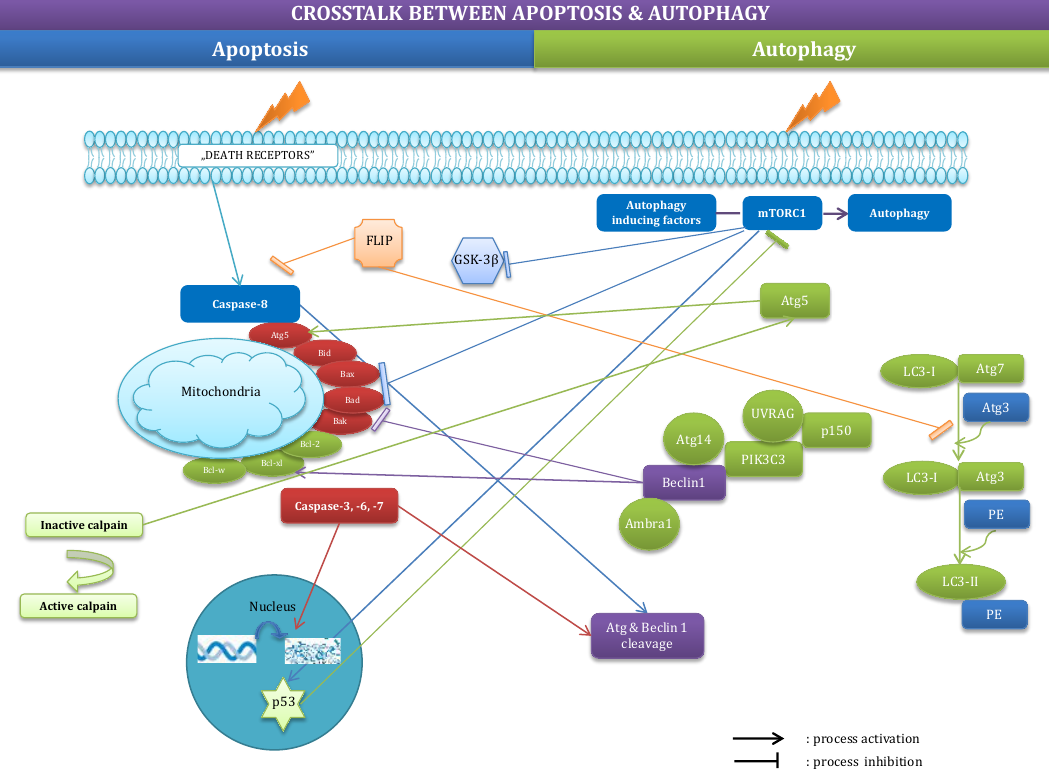
Figure 3. Crosstalk between apoptosis and autophagy. These processes interfere with themselves, mainly with regard to the BCL2 protein family, p53, and Atg5. The crosstalk has been described in detail in part 2.3.